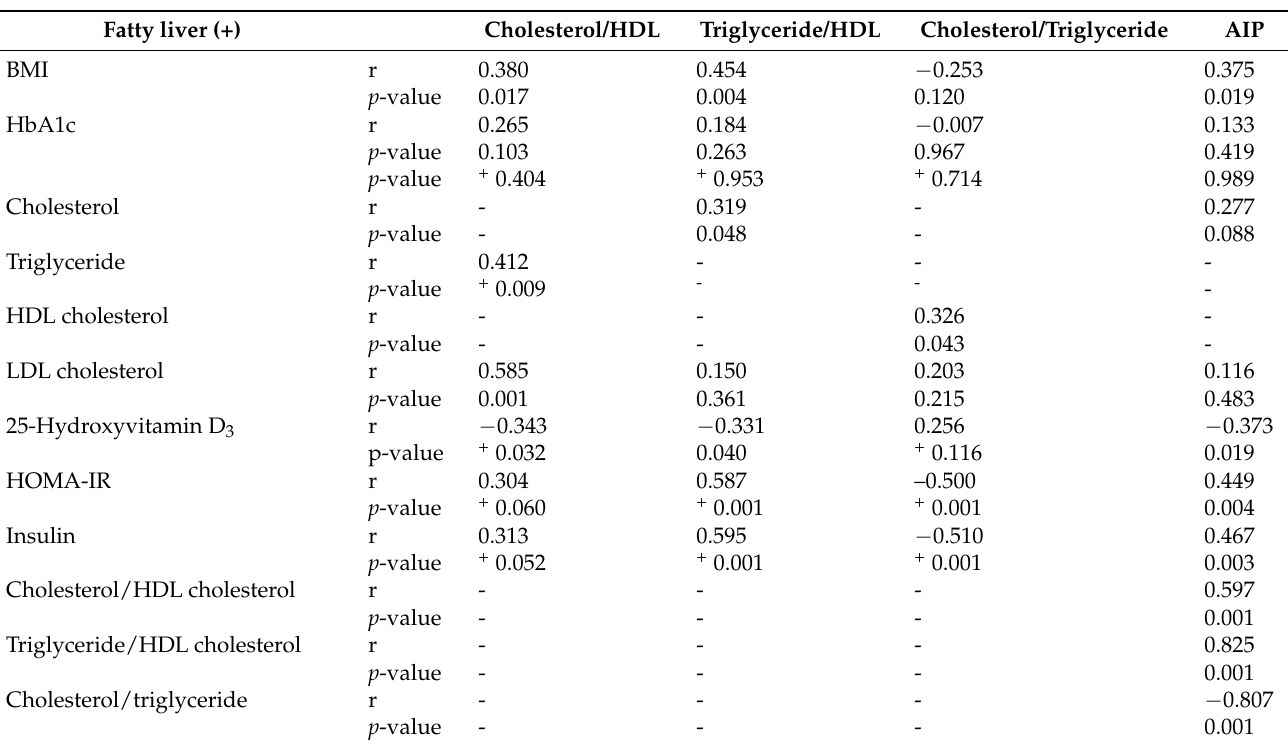
Table 4. Correlations in the obese adolescent group with fatty liver